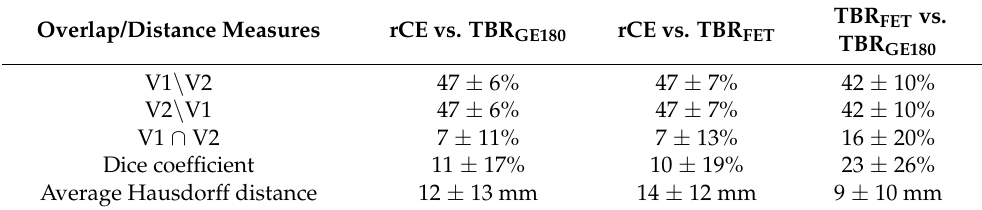
Table 1. Presented are values averaged over all patients and the corresponding standard deviations (mean ± SD) of discordant and concordant sub-volume fractions, Dice coefficients, and average Hausdorff distance measures of hotspots defined in tumor-to-background ratio (TBR) and relative contrast enhancement (rCE) images. The descriptions of the compared volumes V1 vs. V2 are provided in the column labels. Sub-volumes are given as the percentage of the combined volume V1 ∪ V2. V1 \ V2 corresponds to the sub-volume where V1 exceeds V2, and V2 \ V1 is the sub-volume where V2 exceeds V1. V1 ∩ V2 is the overlapping volume fraction.